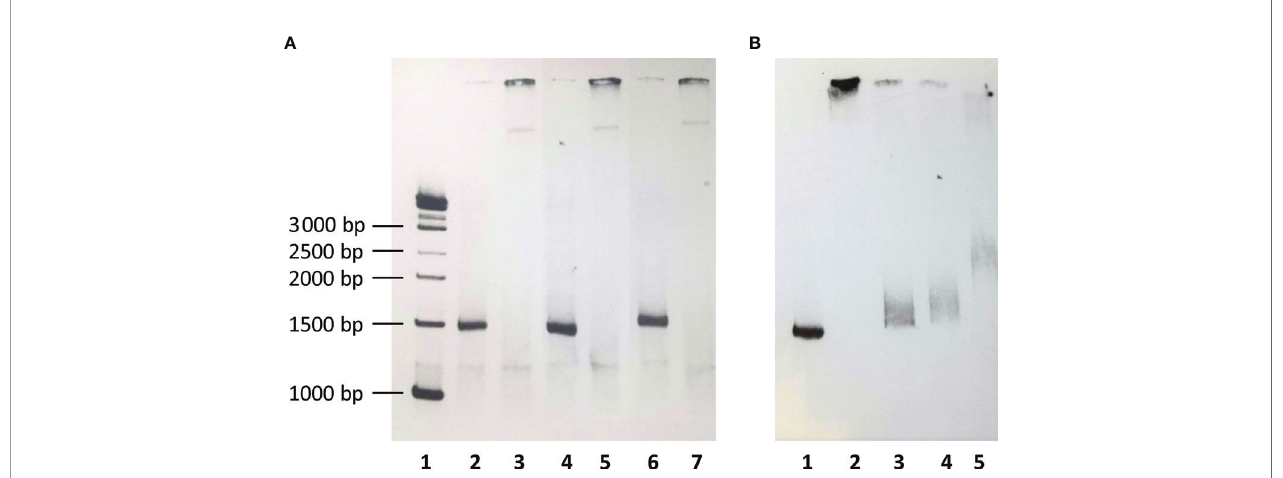
FIGURE 5 | (A) The electrophoretic mobility of biotin-labelled DNA fragment including polymorphic sites at rs11103565, rs7040372, rs7046516, rs7847422, rs7847431, rs6537957, rs6537958, rs6537959, rs6537960, rs6537962, rs11462298 and rs7860507. 1 – biotinylated molecular weight marker; 2, 3 - major allele homozygote; 4, 5 - variant allele homozygote; 6, 7 – heterozygote; lanes 2, 4, 6 – with no nuclear extract; lanes 3, 5, 7 – preincubated with nuclear extract. (B) Inhibition of binding of nuclear extract to aforementioned biotin-labelled DNA fragment from major allele homozygote. 1 – no nuclear extract, no inhibitor; 2 – nuclear extract, no inhibitor; 3 – nuclear extract, unlabelled DNA from major alelle homozygote as inhibitor; 4 - nuclear extract, unlabelled DNA from minor alelle homozygote as inhibitor; 5 - nuclear extract, unlabelled, unrelated DNA as inhibitor (1122 bp PCR product, corresponding to the 134 887 339-134 888 460 region of FCN2 gene.